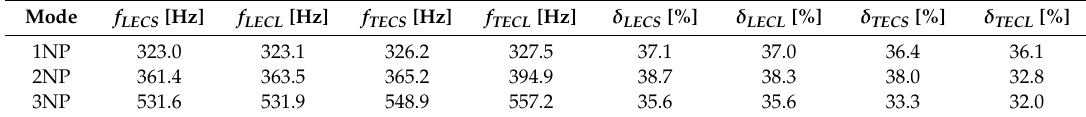
Figure 8. Comparison of the deviation of FRRs for the single blade. To quantify the effect of cavity size, the CSR defined by Equation (15) has been correlated to the FRRs in Figure 9 for the three modes. It can be clearly observed that the added mass effect decreases when the ratio increases. Obviously, TEC has a larger influence on the natural frequencies than LEC. However, between the small and large sizes of TEC there is a sharp decrease of the FRR for the 2NP mode compared with the behavior of the other two modes. The FRR of 2NP is the highest for the first four cases shown in Figure 9. However, with the presence of TECL its value drops down and lies between the FRRs of 1NP and 3NP. This behavior might be due to the effect of the cavity location relative to the maximum blade deformations.